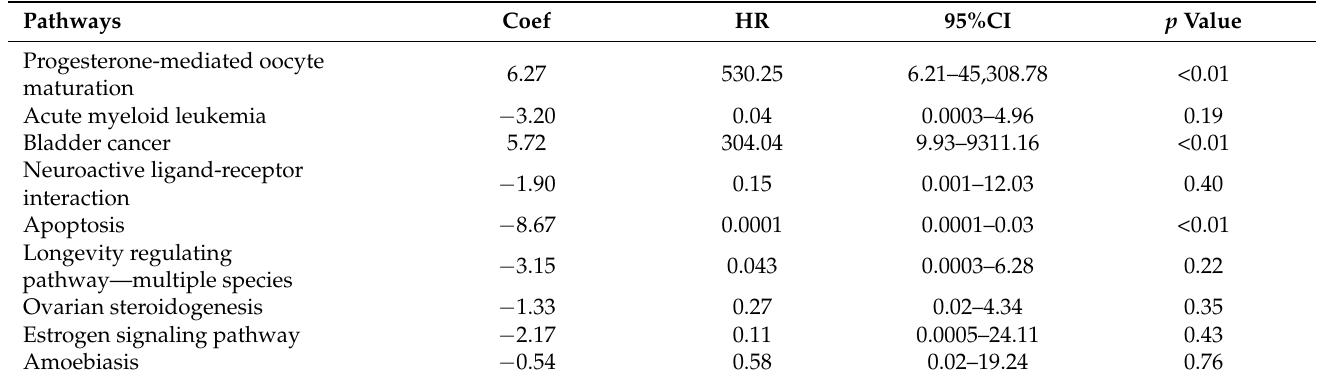
Figure 4. Identification of a 9-pathway signature for overall survival by LASSO regression analysis in Bernard cohort. ( A ) LASSO coefficient spectrum of 12 pathways in breast cancer; the dashed line represents the number of pathways corresponding to the covariates used for multivariate Cox analysis. ( B ) The Kaplan–Meier curves of the IPRS-high and IPRS-low groups in Bernard cohorts. ( C , D ) GSEA plot of significant hallmark pathways ( C ) and KEGG pathways ( D ) in comparison between the IPRS-high and IPRS-low groups. Table 1. The identified significant signaling pathways and their coefficients were calculated by the multivariate Cox regression model.